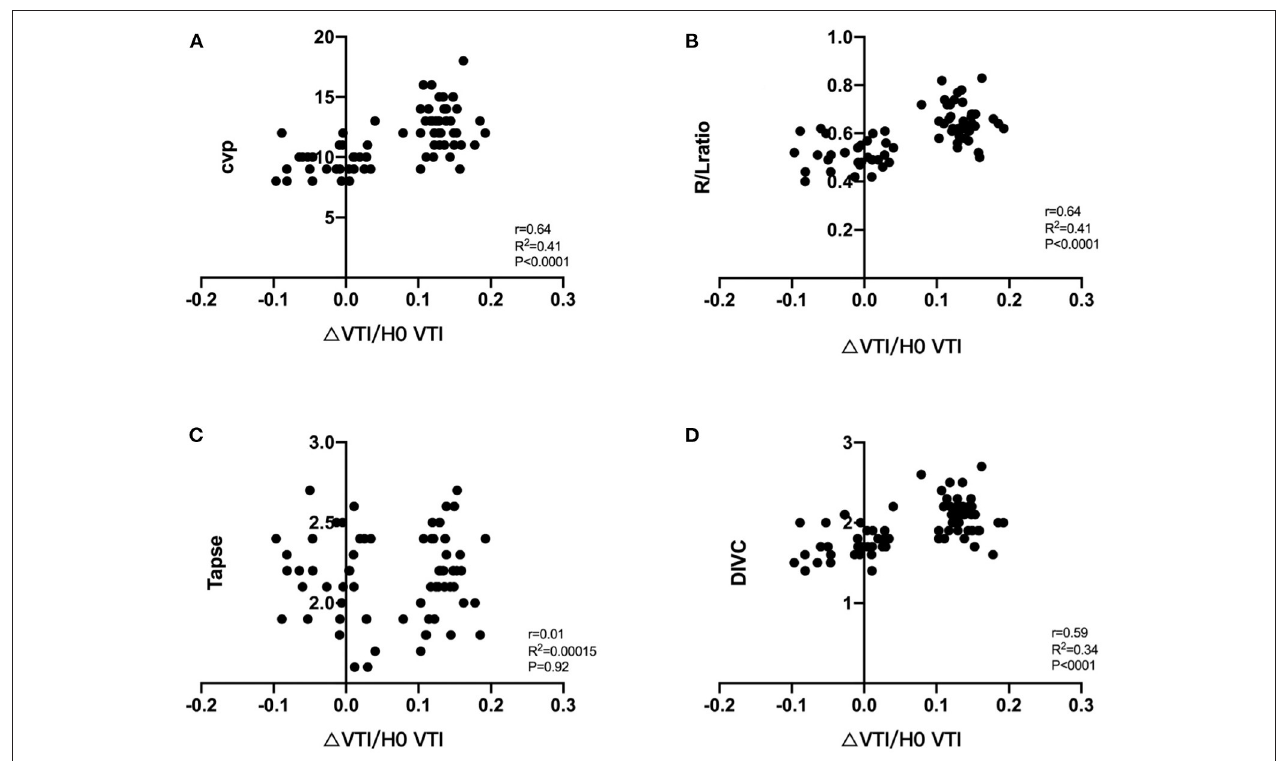
FIGURE 4 | Correlation between 1 LVOT VTI/T0 LVOT VTI and RV parameters, 1 LVOT VTI/T0LVOT VTI = T1LVOT VTI-T0 LVOT VTI/T0LVOT VTI, its relationship with CVP (A) , RV D /LV D ratio (B) , TAPSE (C) , DIVC end − expiratory (D) . VTI, velocity time integral; CVP, central venous pressure; TPASE, tricuspid annular plane systolic excursion; RV D /LV D ratio, right to left ventricular diastolic dimensions ratio; DIVC end − expiratory, diameter of the inferior vena